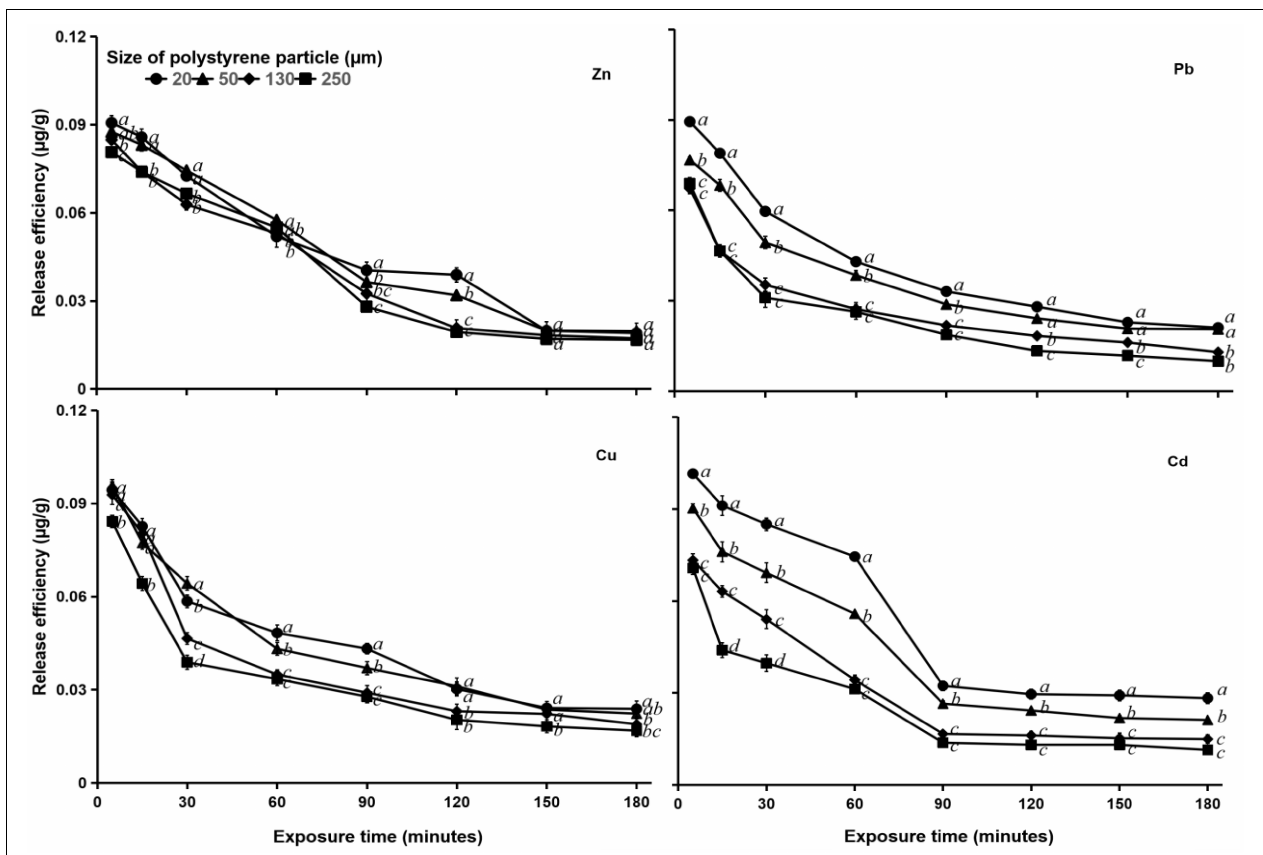
FIGURE 7 | Heavy metal (Zn, Pb, Cu, and Cd) release efficiency ( µ g g − 1 ) in MPs of different sizes (20, 50, 130, and 250 µ m) in water with a salinity of 30 Figure 5 for statistical information.